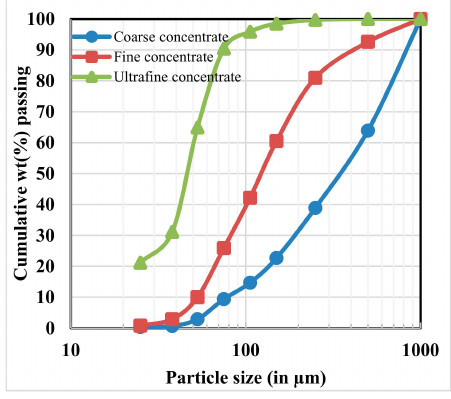
Figure 1. Particle size distribution of the chromite concentrates. Table 2. Elemental assay of the concentrates.